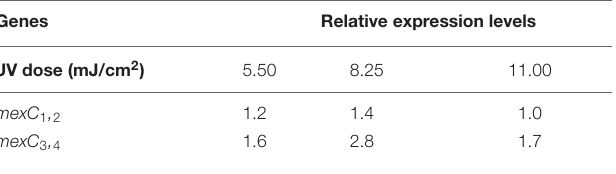
TABLE 2 | Changes in relative expression levels of select P. aeruginosa genes during UV exposure. Genes Relative expression levels UV dose (mJ/cm 2